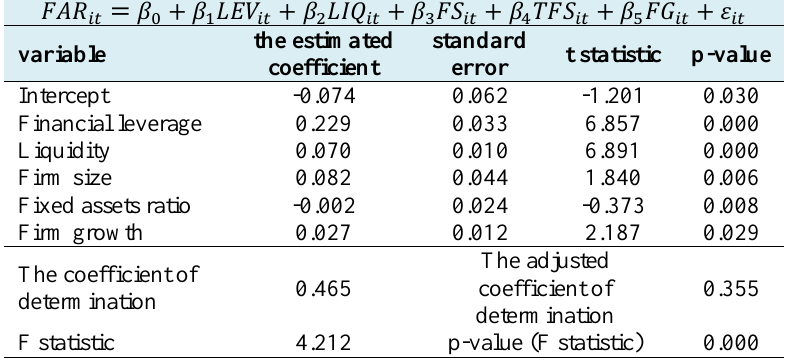
Table 22. The results of estimating the first model of research in the BSE (without considering the effects of the inflation